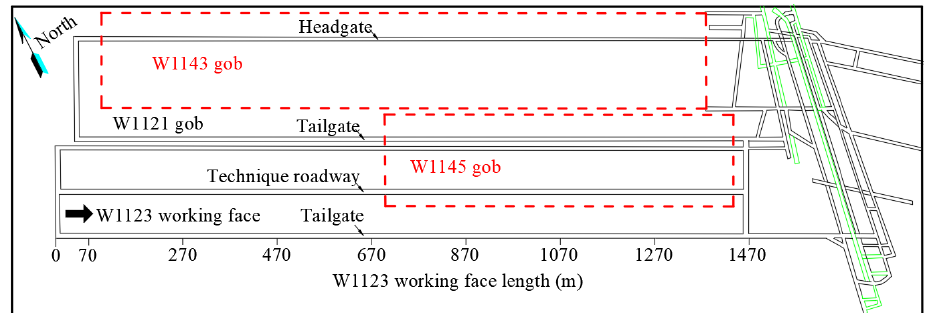
Figure 2. Roadway layout of the W1123 working face. There is a risk of impact of the mining process on the working face; thus, it is neces- sary to drill a large-diameter hole to relieve the pressure of the roadway. This paper takes the transportation roadway of the W1123 fully mechanized top-coal caving face as its re- search object. The section of the roadway is arc-shaped, and the section size (width × height) is 4.7 m × 3.4 m. It is supported by a bolt (cable), anchor net, and steel belt.